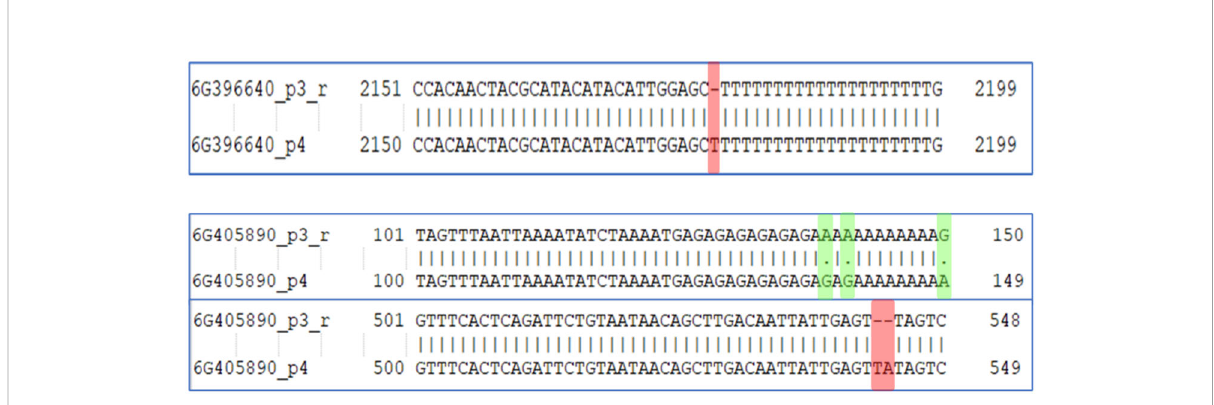
FIGURE 8 Variation in the Csa_6G396640 and Csa_6G405890 genes associated with indole-3-pyruvate monooxygenase YUCCA11 and Auxin response factor 16, respectively in the parents PU (p3_r) and PPC-6